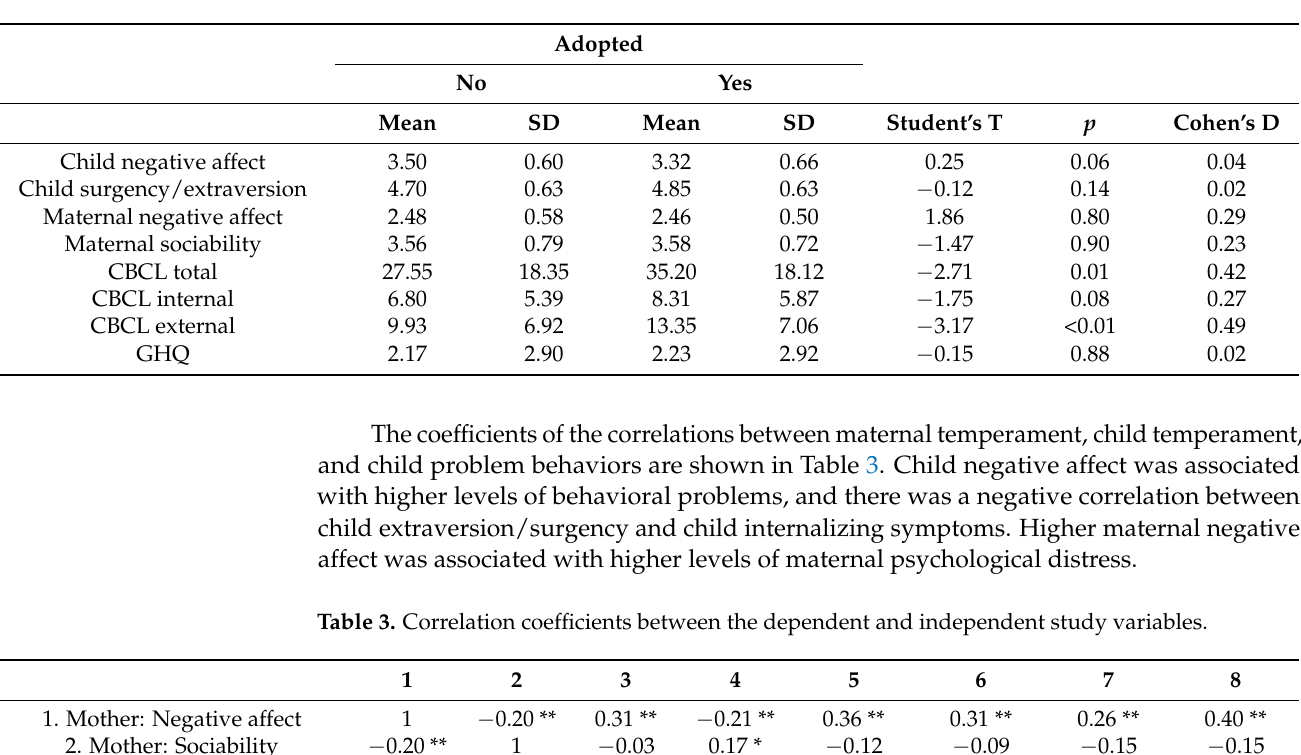
Table 2. Comparison of descriptive statistics according to adoption status.